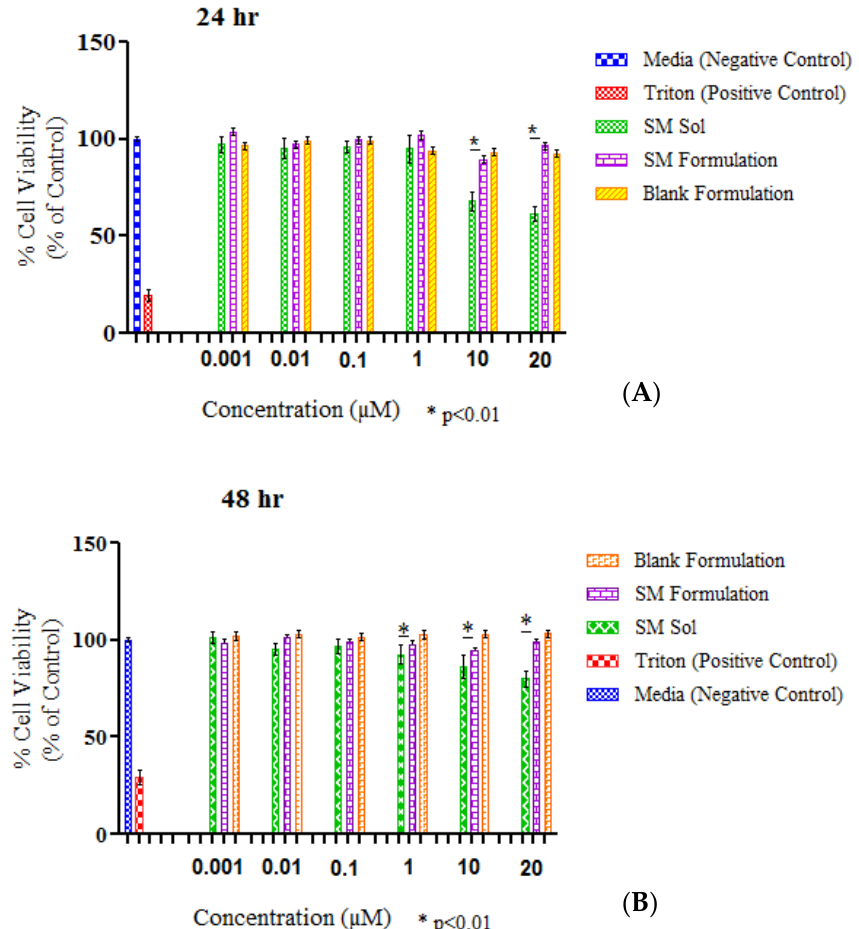
Figure 5. Percent cell viability at various concentrations of the sunitinib drug solution and the SM- MPEG-PCL formulation at ( A ) 24 and ( B ) 48 h on the ARPE-19 human retinal cell line (mean ± SD, n = 4).